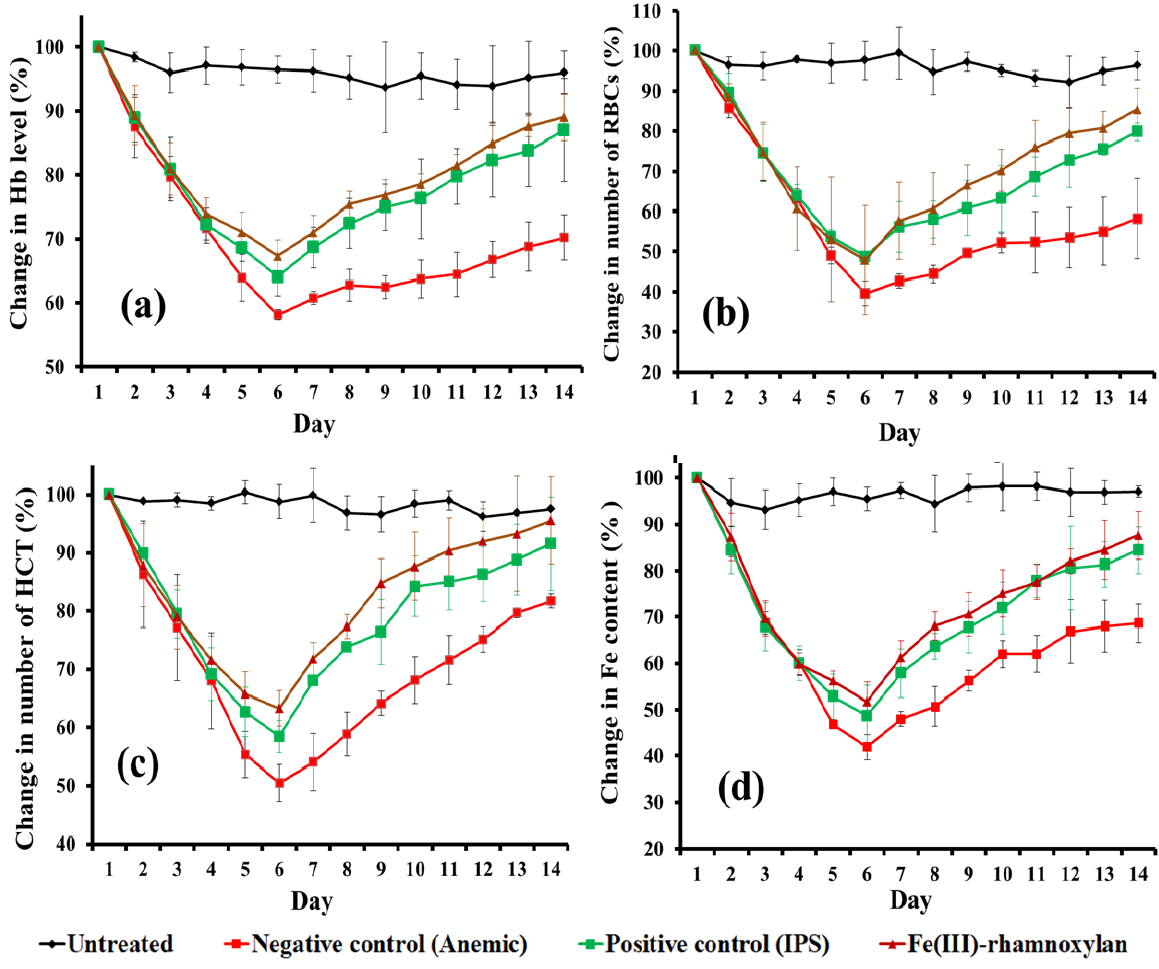
Figure 13. Effect of Fe(III) ‐ rhamnoxylan on ( a ) % Hb, ( b ) % RBCs, ( c ) % HCT and ( d ) Fe content.